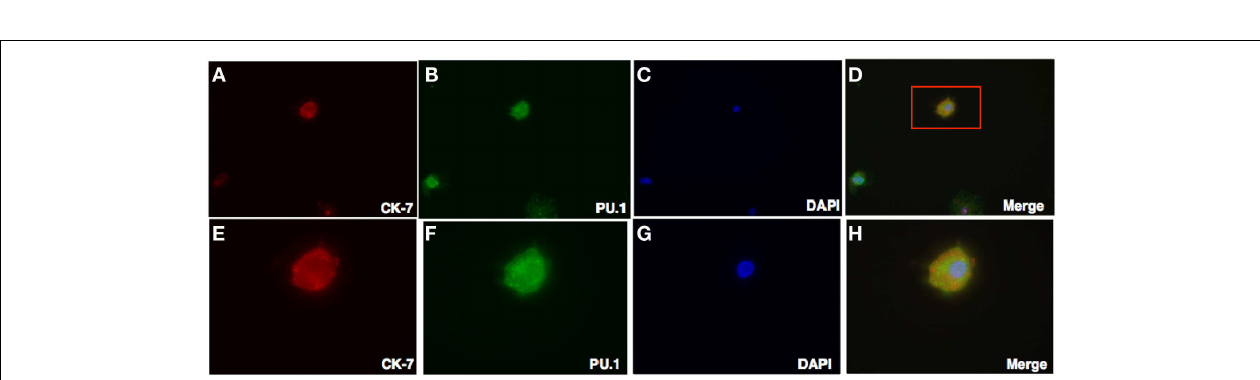
FIGURE 6 | Double Intracellular immunofluorescence staining of PU.1 and trophoblasts in first trimester decidua . Decidual cells cytospun were fixed, permeabilized, and then immunostained with mouse anti-human CK-7 and rabbit anti-human PU.1 antibodies.This was then probed with goat-anti-mouse